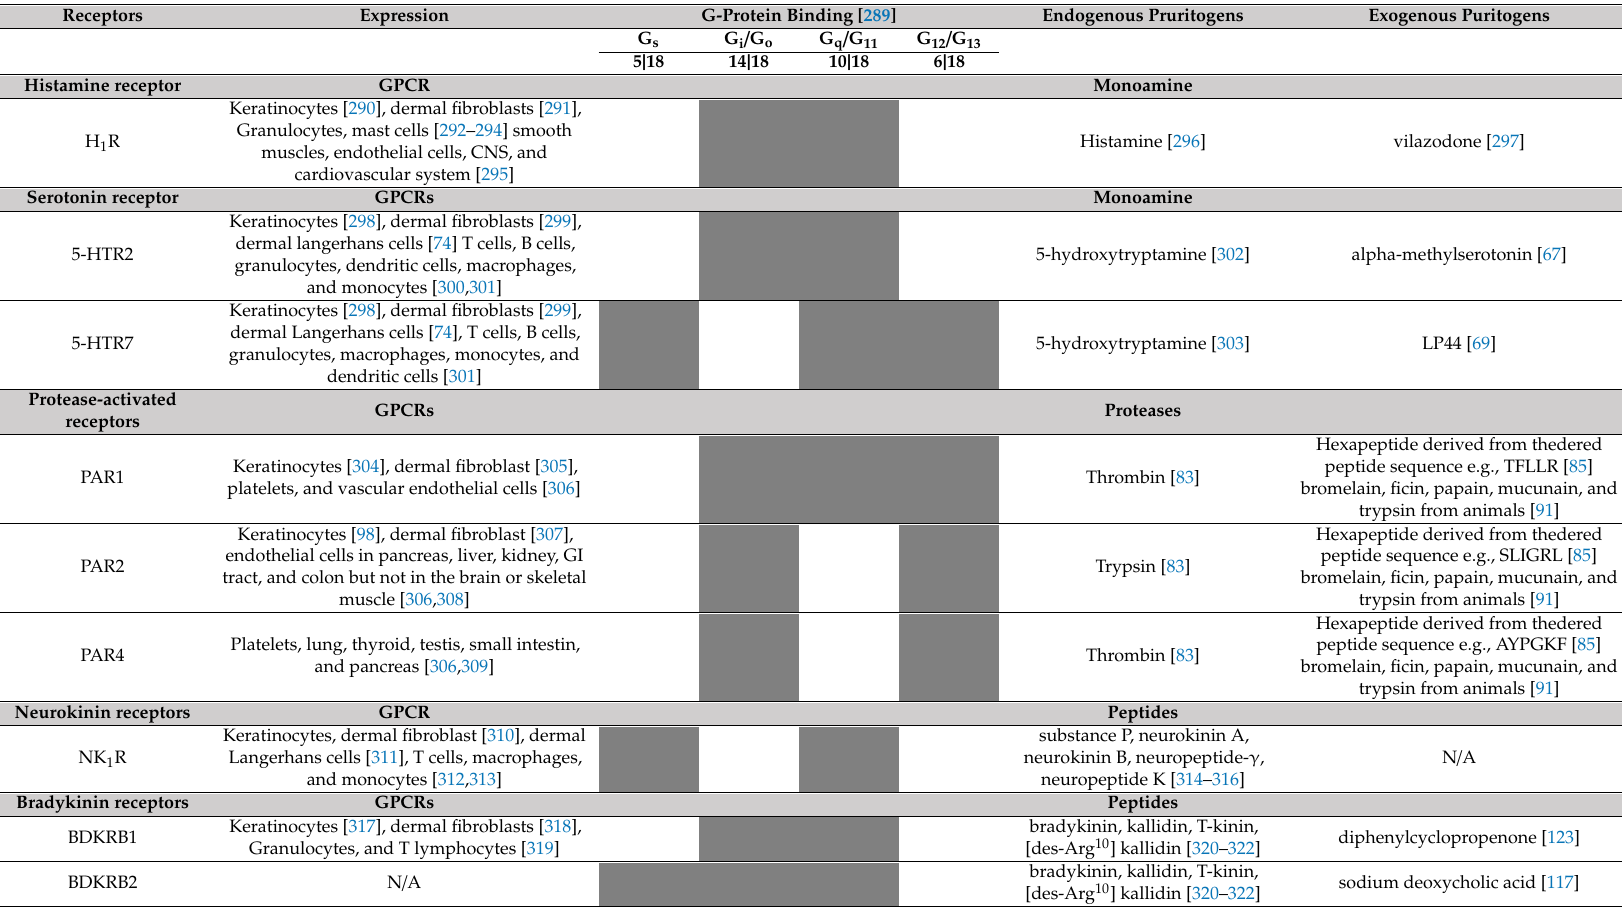
Table 2. Exogenous and endogenous pruritogens, their receptors, expression levels and